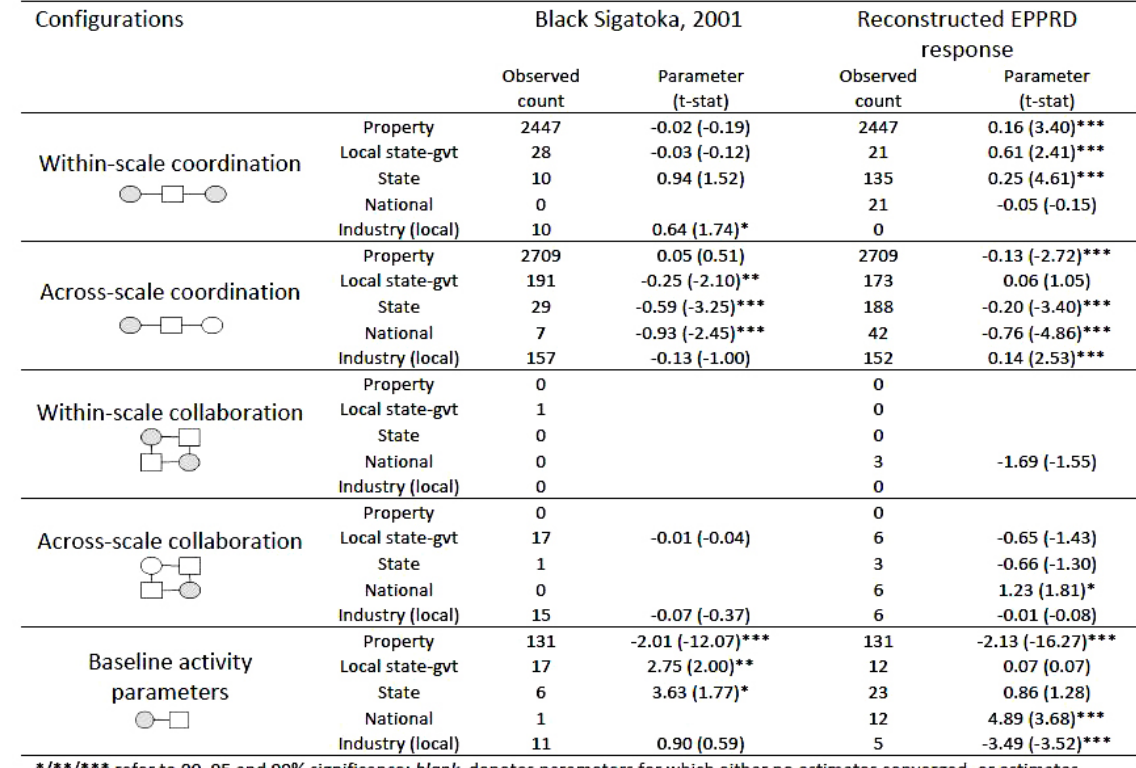
Fig. 6 . Summary of Exponential Random Graph Modeling (ERGM) results. Counts show observed number of configurations in both networks; negative/positive ERGM parameters measure whether observed counts are fewer/ greater than expected by chance alone, with t statistics used to access the statistical significance. As in Figure 4, shaded circles in configurations imply that stakeholders must be of a given scale, e.g., grower, local industry or local state government representative, state or national government. EPPRD indicates Emergency Plant Pest Response